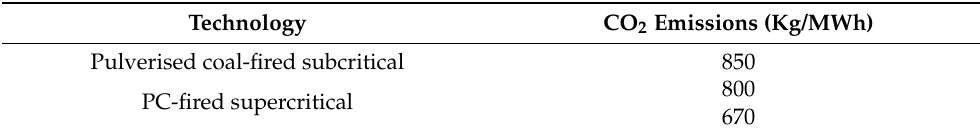
Table 4. CO 2 emissions from several power generation technologies